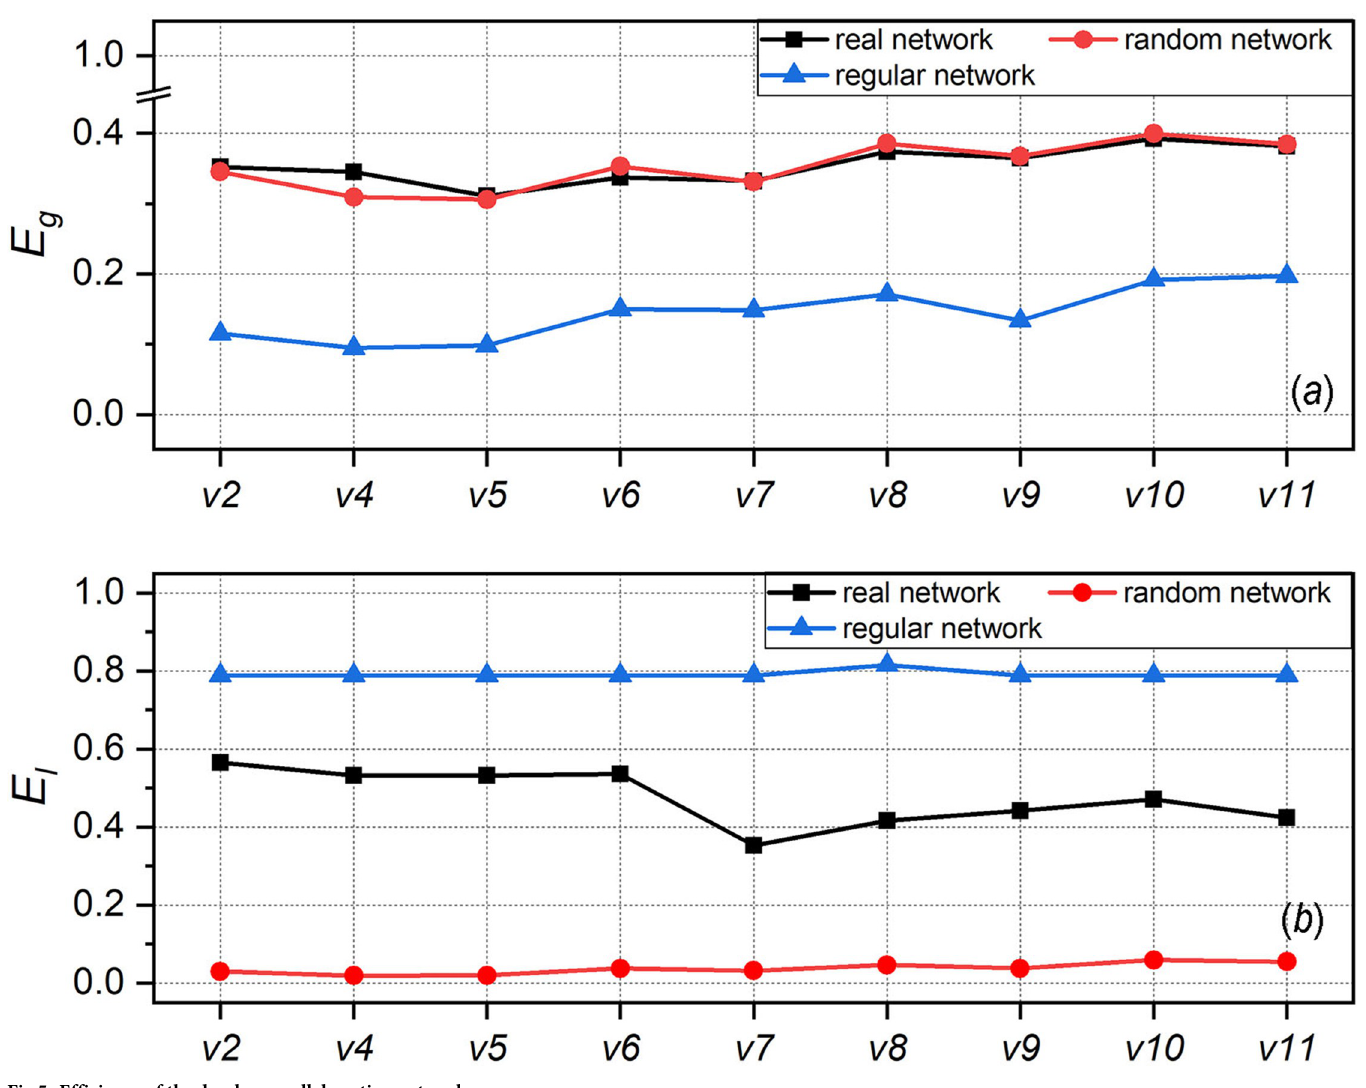
Fig 5. Efficiency of the developer collaboration